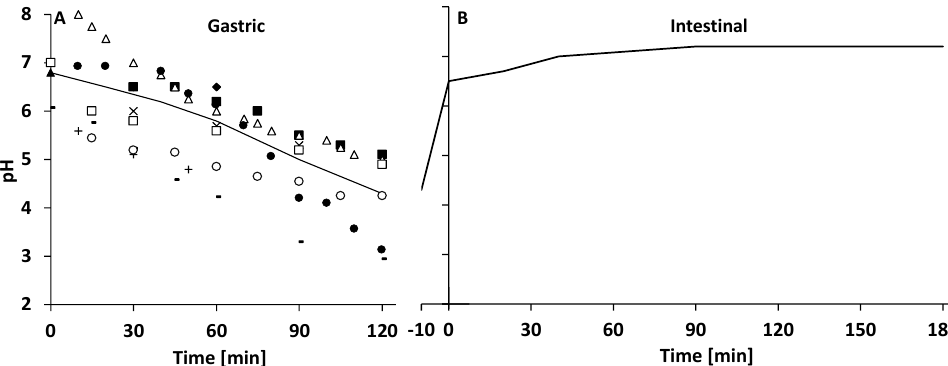
Figure 2. SIM pH curves. ( A ) Pre-set gastric pH curve (straight line) and in vivo reference values from: [21], ◆ [22], [23], [24], [25], [26], [27], [28], ⚫ [29], and [30]. ( B ) Pre-set intestinal pH curve based on values used by Blanquet et al. in TIM-1 [31]. Pre-set gastric pH curve is polynomial (3rd order) trendline of mean in vivo pH per timepoint.